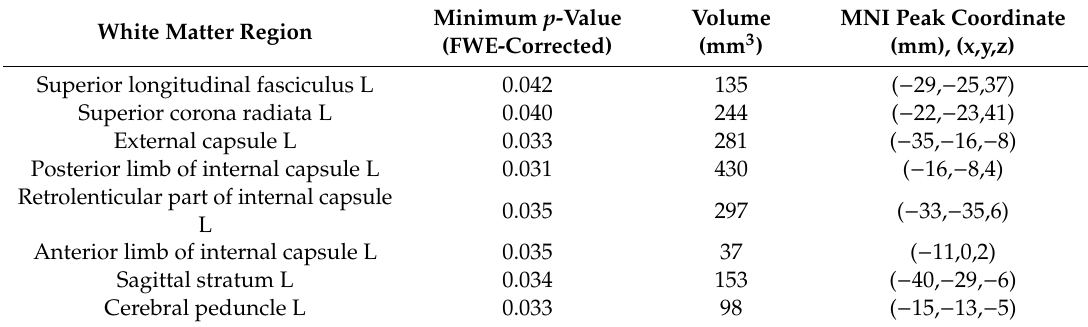
FWE = Family-wise error; L = left; R = right. The column volume represents the volume from the atlas region with significant results. No regions with a volume equal or lower than 30 mm 3 were included in this table. Table A13. White matter regions from the ICBM-DTI-81 White Matter Atlas for which significant decreased RTPP values were found in EM compared to HC including the duration of the migraine, presence of aura and medication overuse headache as covariates.